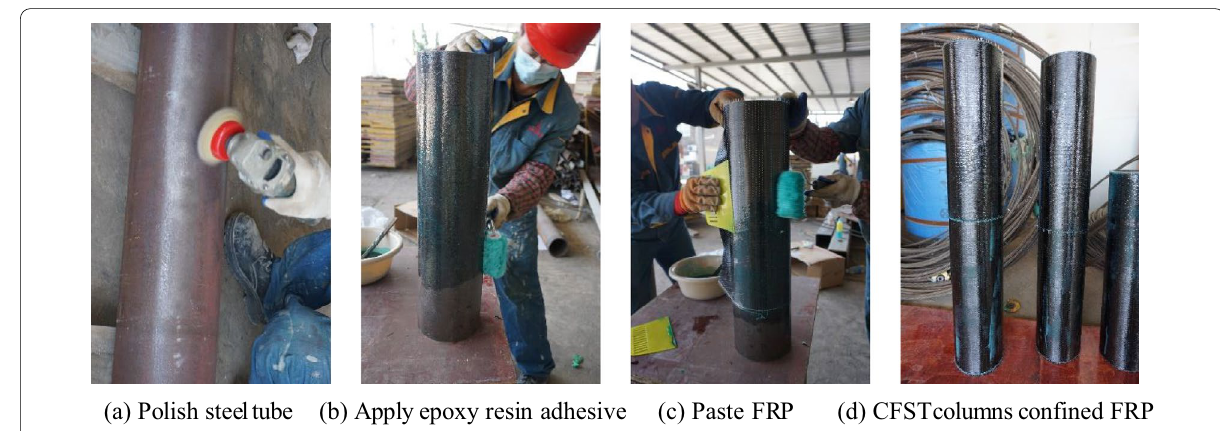
Fig. 4 Production process of pasting